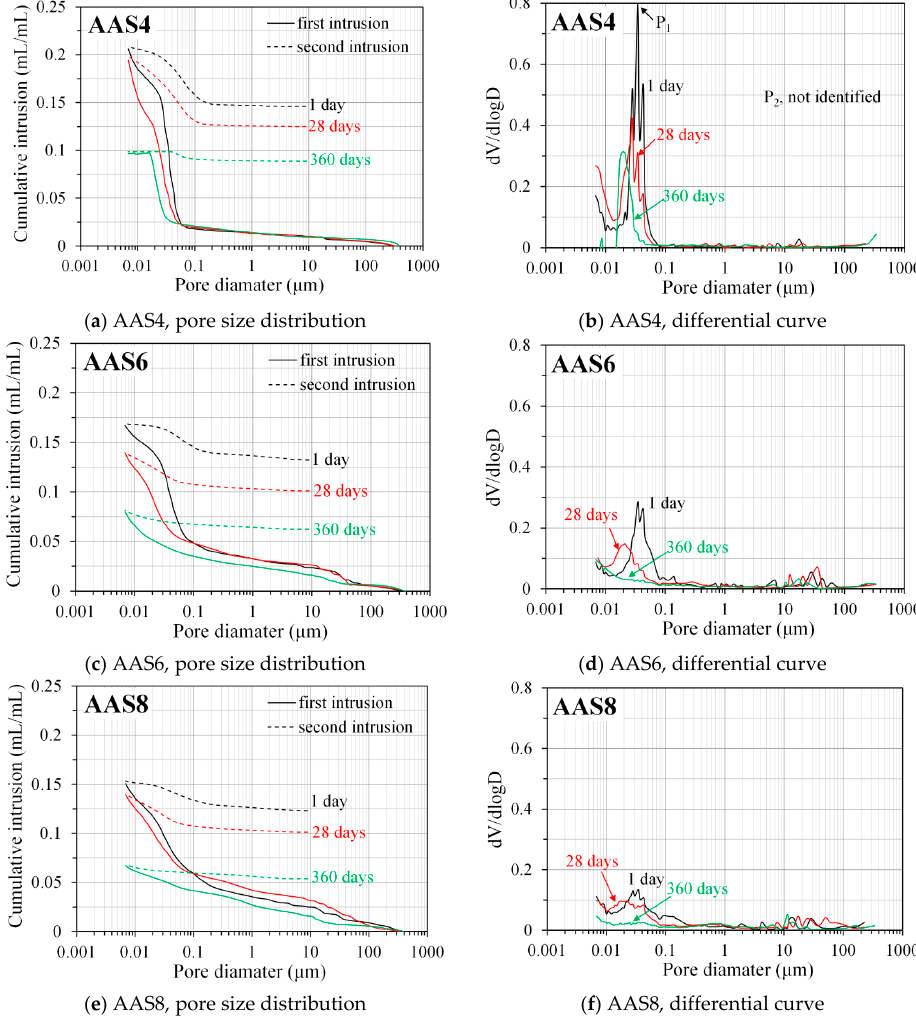
Figure 8. Pore size distribution and differential curves, derived from MIP, for AAS4 ( a , b ), AAS6 ( c , d ), and AAS8 ( e , f ) at 1, 28, and 360 days (the data at 7, 90, and 180 days are shown in Figure S1, as included in the Supplementary Materials). In the graphs, P 1 and P 2 are the first and second peak respectively (here P 2 is not identified), AAS indicates alkali-activated slag, the number following AAS refers to the weight percentage of Na 2 O with respect to slag. For all samples, the water to slag ratio was 0.4 and the curing temperature was 20 °C.